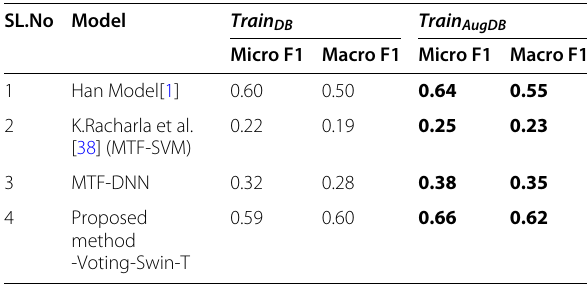
Table 4 Effect of data augmentation. The highest values are